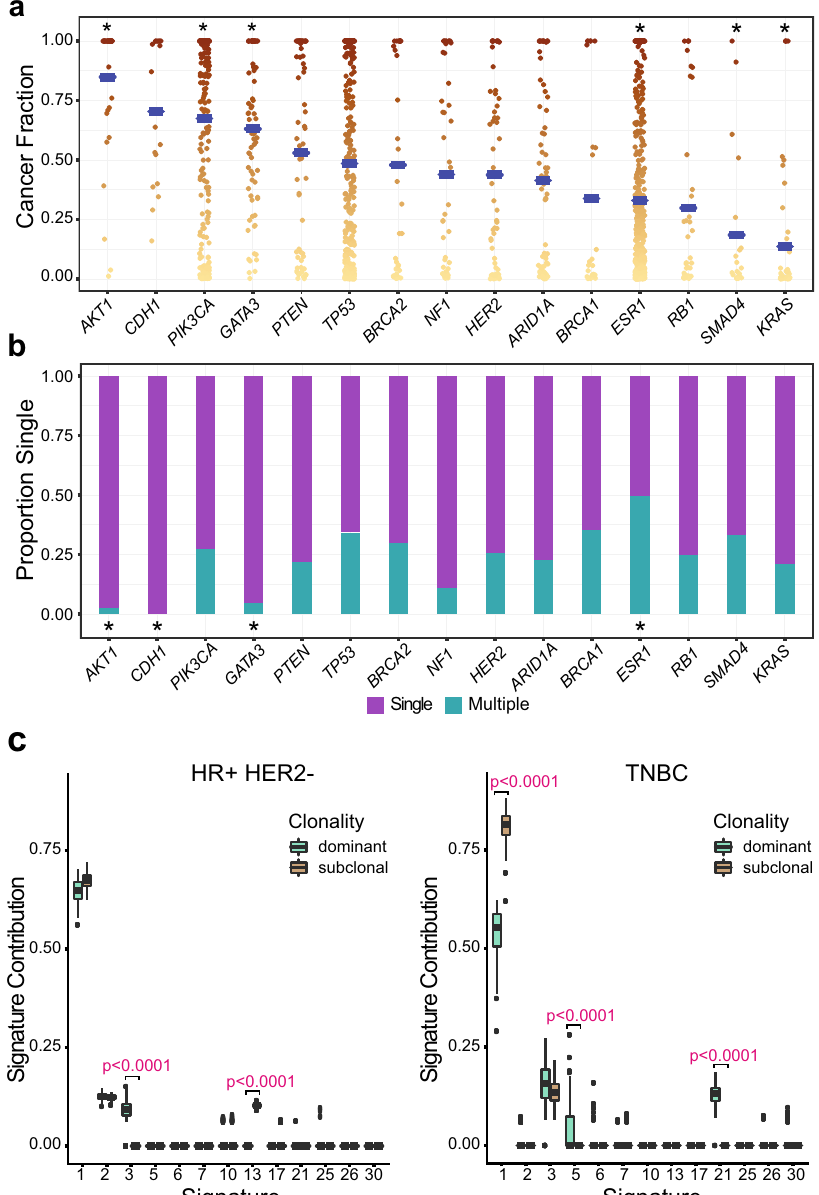
Fig. 5 Clonal dominance and mutational signatures in dominant and subclonal mutations. a Cancer fractions of mutations in indicated genes, ordered by mean cancer fraction ( N = 1974 mutations with assessable cancer fractions). The mean value is indicated with a blue line. *indicates signi fi cant difference in cancer fraction compared to remaining cases, false discovery corrected two-sided Wilcoxon signed-rank test ( AKT1 q < 0.0001, PIK3CA q < 0.0001, GATA3 q = 0.0003, ESR1 q < 0.0001, SMAD4 q = 0.02, KRAS q < 0.0001). Cancer fraction — allele fraction of the mutation relative to the maximum somatic allele fraction in the sample. b Proportion of mutations that occur as a single versus multiple mutations per patient in indicated genes. *indicates signi fi cant difference in proportion to single to multiple mutations in the gene compared to remaining cases, false discovery corrected two-sided Fisher ’ s exact test ( AKT1 q = 0.0009, CDH1 q = 0.05, GATA3 q < 0.0001, ESR1 q < 0.0001). c Bootstrap mutational signature analysis on aggregated mutations from all HR + HER2- ( left , clonally dominant mutations N = 328, subclonal mutations N = 968) and TNBC ( right , clonally dominant mutations N = 121, subclonal mutations N = 190) breast cancers, for dominant and subclonal mutations. Signature contributions for clonal versus subclonal alterations were ascertained using deconstructSigs and compared using a two-sided Mann – Whitney U -test. Signatures with signi fi cant difference in signature contribution and no overlap in interquartile range are identi fi ed with the p -value (HR + HER2-: signature 3 p < 0.0001, signature 13 p < 0.0001; TNBC: signature 1 p < 0.0001, signature 5 p < 0.0001, signature p <